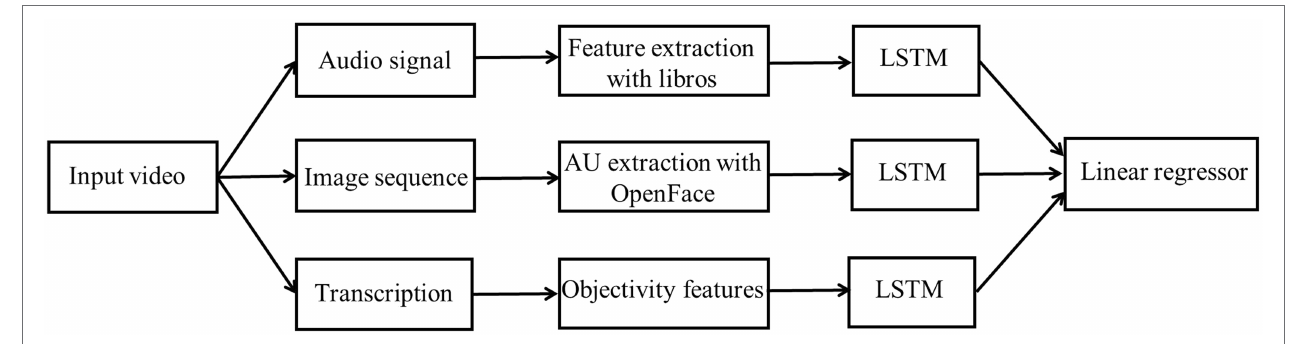
FIGURE 7 | The flowchart of Integrating audio, vision and language for first-Impression personality analysis (Gorbova et al.,